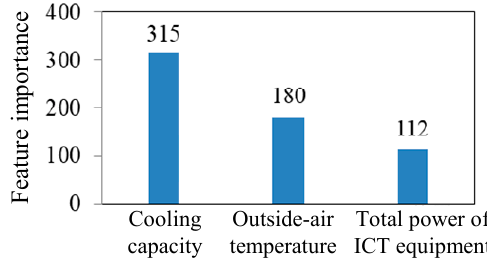
Figure 13. Importance of explanatory variables used in the baseline model. Table 18. Explanatory variables used in the baseline model. Learning Period No.